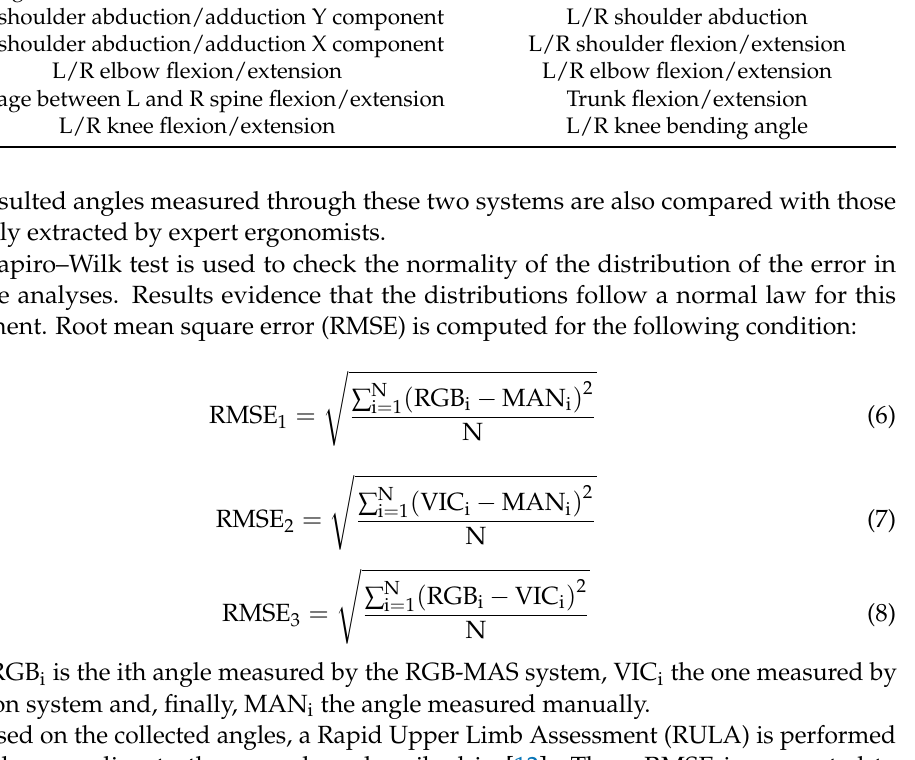
Table 2. Pairs of angles that have been compared between Vicon and RGB systems. Pairs of Angles Compared between the Two Systems. Vicon RGB-MAS Average between L and R neck flexion/extension Neck flexion/extension L/R shoulder abduction/adduction Y component L/R shoulder abduction L/R shoulder abduction/adduction X component L/R shoulder flexion/extension L/R elbow flexion/extension L/R elbow flexion/extension Average between L and R spine flexion/extension Trunk flexion/extension L/R knee flexion/extension L/R knee bending angle